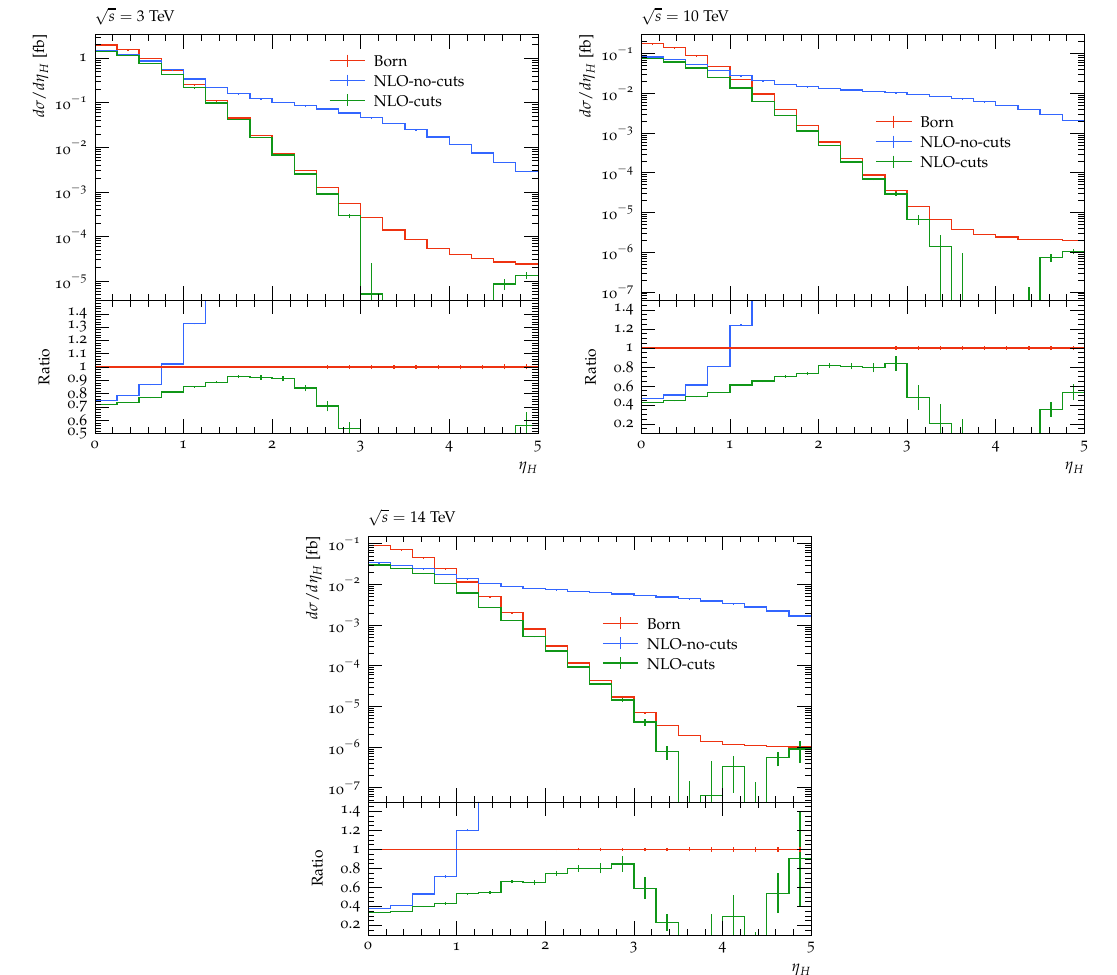
√ s = 3 , 10 and 14 TeV,